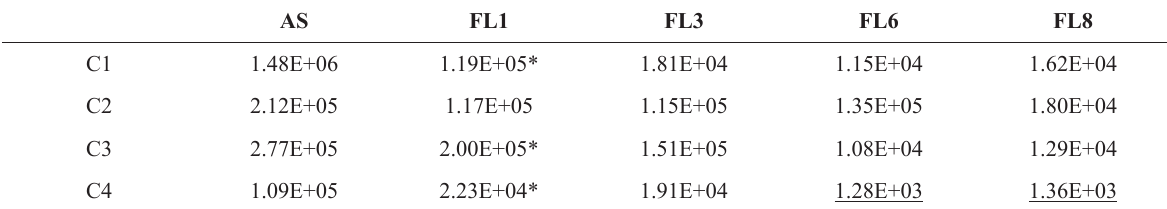
Quantification of mesophilic heterotrophic bacteria in active sludge and facultative lagoons.